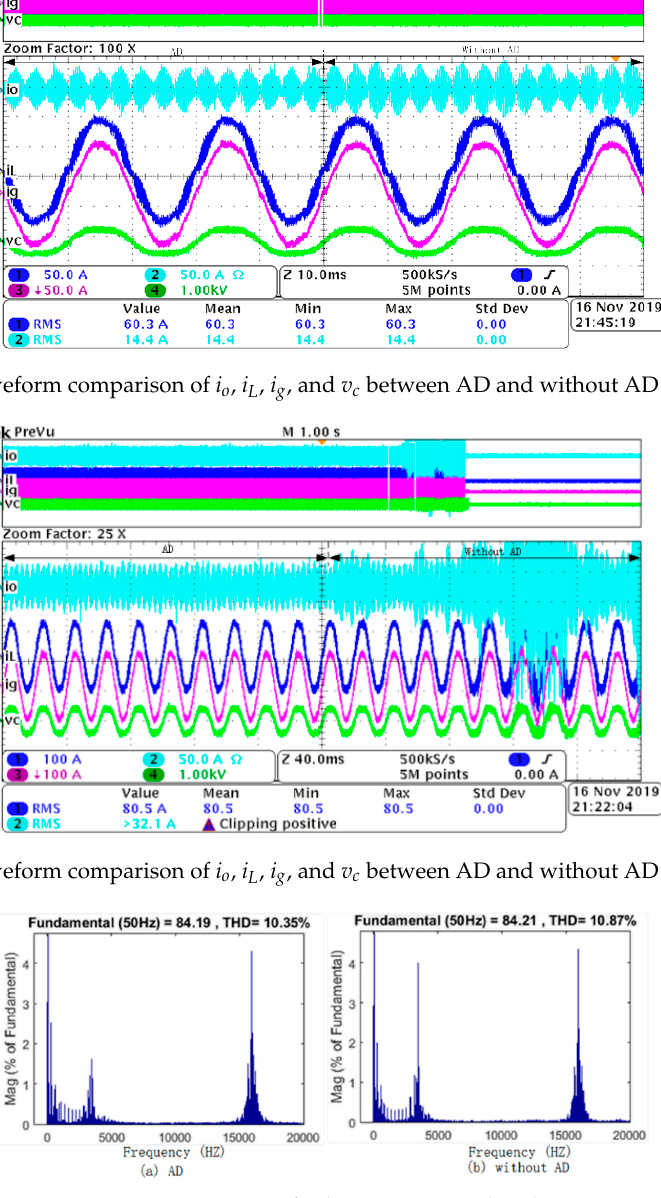
Figure 19. Harmonics comparison of i L between AD and without AD at 60A i L .